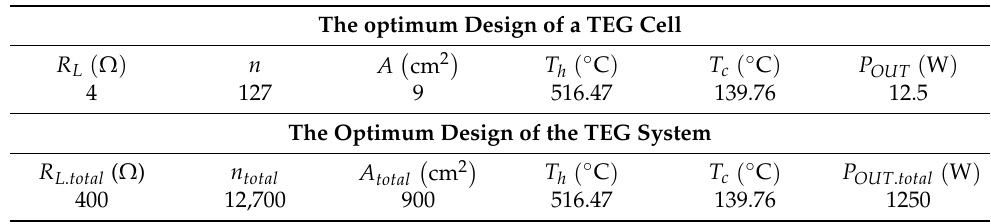
Figure 10. The relationship between the number of thermoelements, TEG system power output, and thermoelectric efficiency. Table 2. The optimum TEG system parameters of the analytical